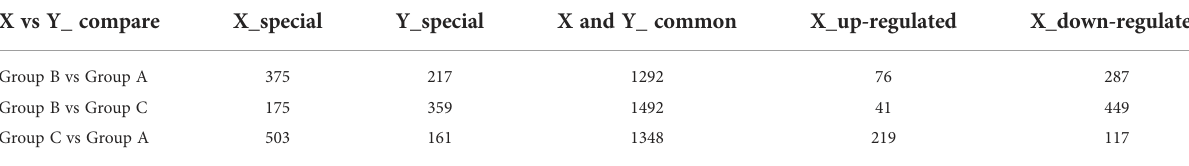
TABLE 1 DEPs identi fi ed in group B vs group A, group B vs group C, and group C vs group A. X vs Y_ compare